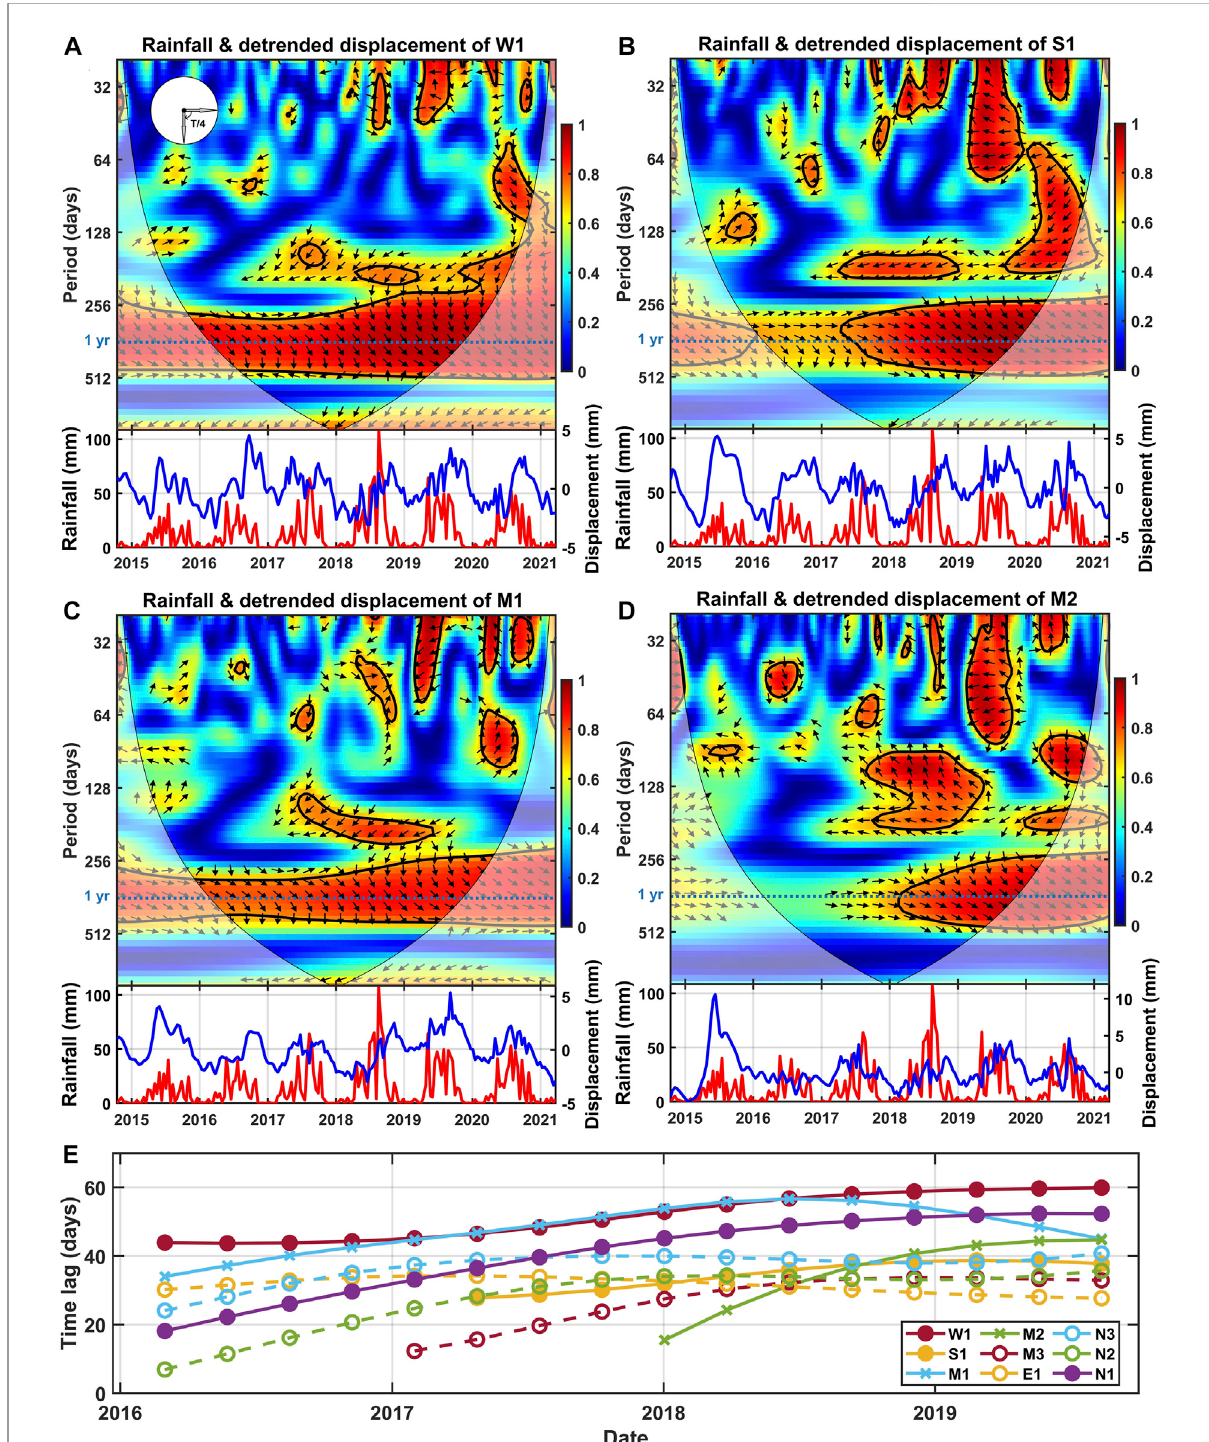
Wavelet coherence (A – D) and progression of time lag (E) on different pairs of time-series data. (A – D) show wavelet coherence between precipitation (red lines) and the displacement (blue lines) of W1, S1, M1, and M2 and variations of the time lag between them, respectively. The time- series displacements have been multiplied by − 1 for better comparison, so the negative increment in displacements means approaching to the satellite.ItistobenotedthatonlythedataoutsidetheCOIandintheblackthickcontoursarereliable.Thedottedlineinbluecorrespondstothe periodof1 year.Redcurvein (A – D) correspondstoprecipitation,andbluecurvecorrespondstodisplacement.Theblackthickcontoursindicatethe